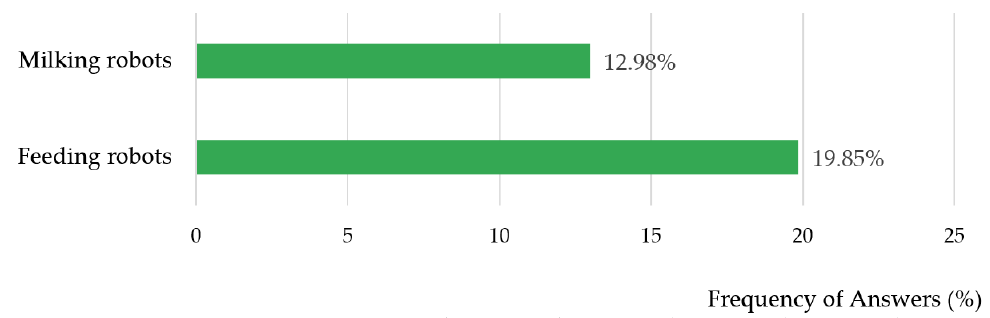
Figure 4. Use of Robots in Livestock Production.